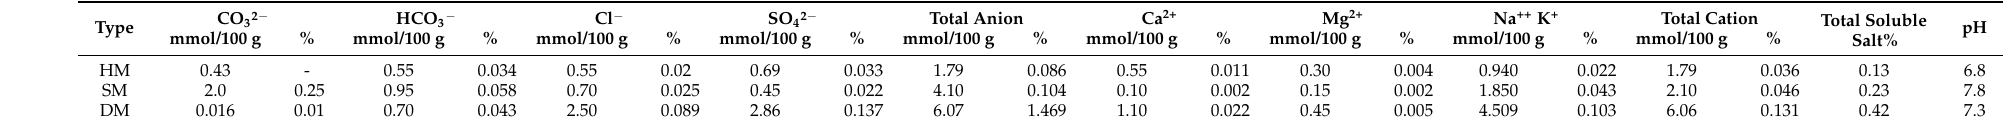
Table A1. The concentrations of soluble salts in DM, HM, and SM